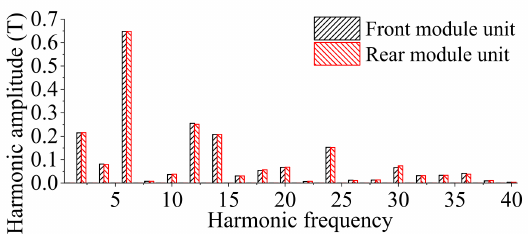
Figure 7. PM air-gap flux density and harmonic distribution for AMC-FRPM machine.